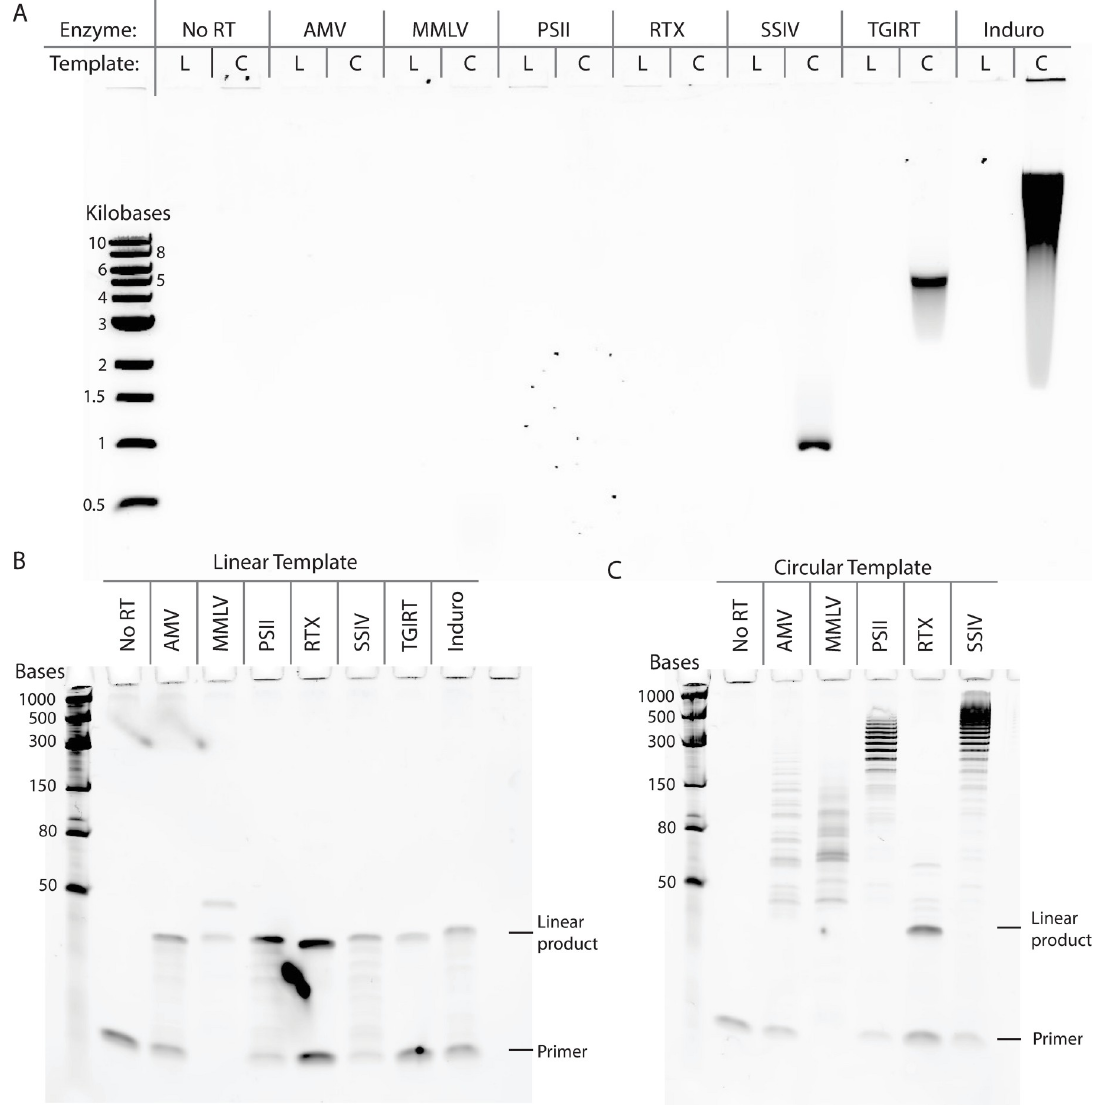
Fig 1. Comparison of rolling circle reverse transcription ability by various reverse transcriptases. (A) Agarose gel electrophoresis was applied to visualize the large cDNA products. Each enzyme was evaluated with both a linear (L) and a circular (C) RNA template. The same reactions products were also resolved by denaturing PAGE gel electrophoresis to visualize the small cDNA products with the (B) a linear RNA template and (C) a circular RNA template.